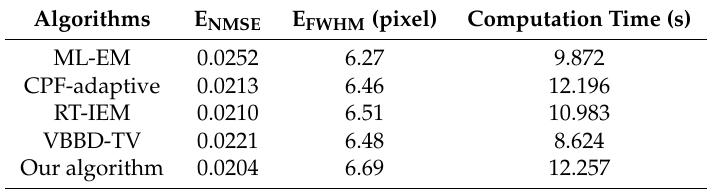
Table 3. The E NMSE , E FWHM , and the computation time comparison for the five algorithms for binary-star images restoration (iteration number is